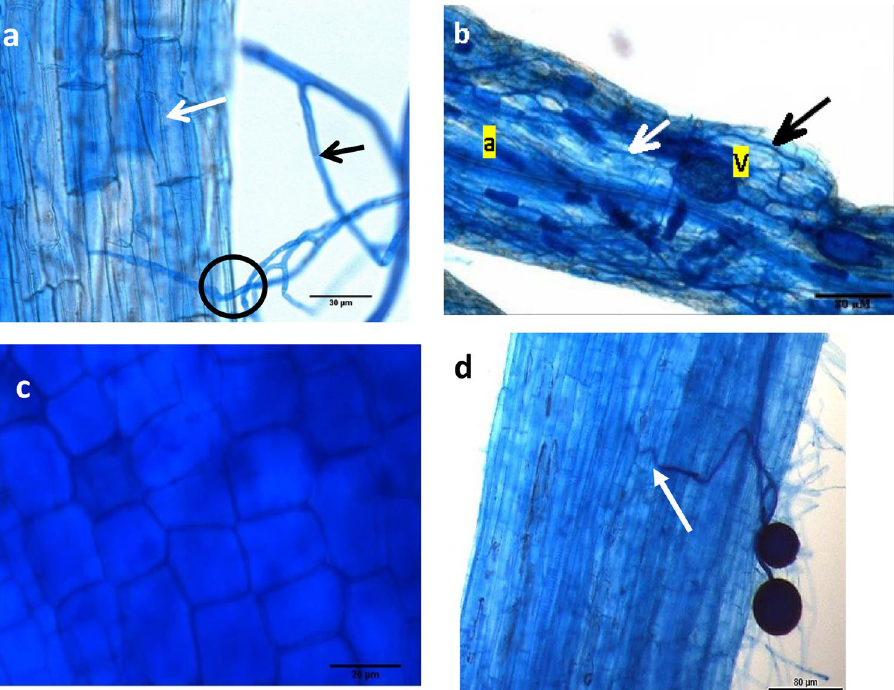
Figure 2. Screening of root cultures for host and non-host potential with respect to the AM symbiosis. ( a ) Possible point of entry of AM fungus into the root segment (appressorium; depicted by black circle) might be representative of initial contact enabling AM fungal penetration into the roots; ( b ) Established host culture showing well developed vesicles (V) and collapsing arbuscules ( a ) connected via hyphal network (white arrow shows the host cells while the black arrow shows AM fungal hypha); ( c ) Tomato cv. Grafter root cortical cells devoid of any AM fungal structures confirm their inability to sustain the symbiosis, ( b ) root segments of tomato cv. Grafter that has possible signs of mycorrhizal entry (white arrows) but no markers of successful symbiosis such as well-developed hyphal network, arbuscules or